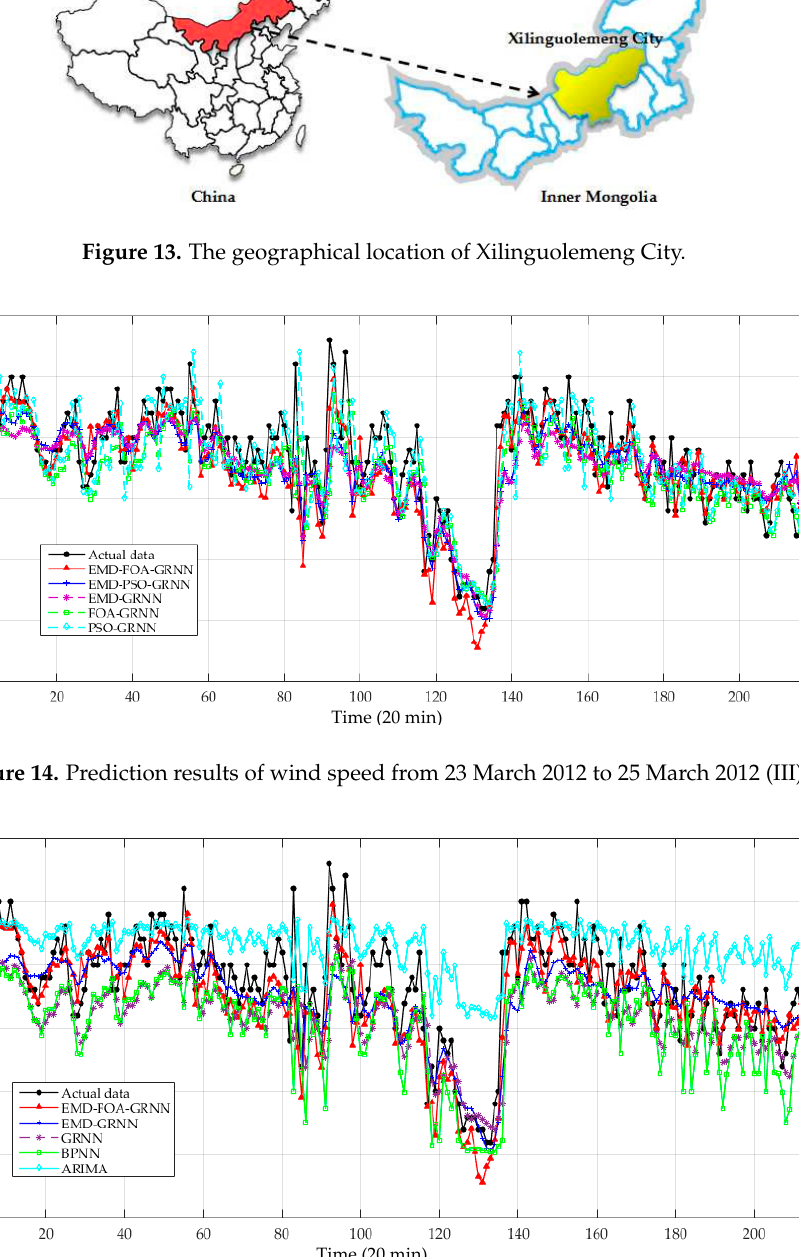
Figure 15. Prediction results of wind speed from 23 March 2012 to 25 March 2012